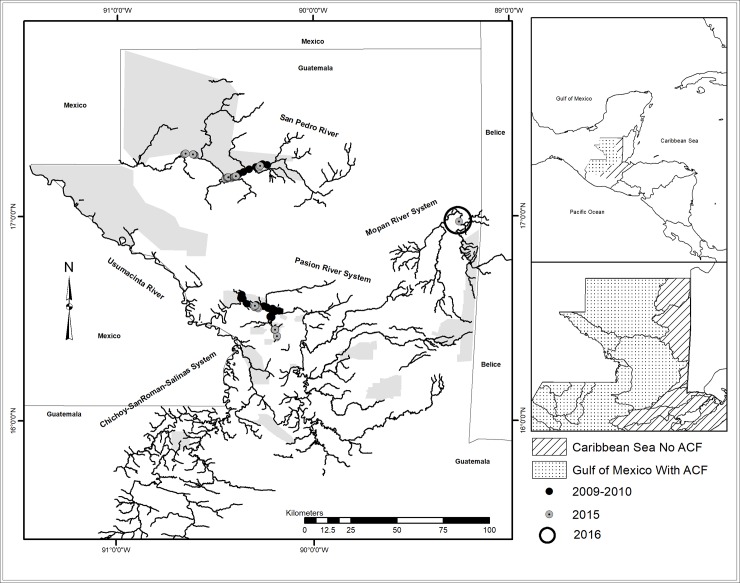
Study area for collection of Neotropical river otter scats in northern Guatemala.Grey circles represent samples collected in 2009–2010; black solid circles represent samples collected in 2015; black hollow circle represents the area where samples were collected in 2016. The dashed area represents the Usumacinta basin divided in sub-basins, where the armored catfish has been reported (ACF). The striped area represents the Caribbean runoff where no ACF has been reported. Grey areas represent protected areas.